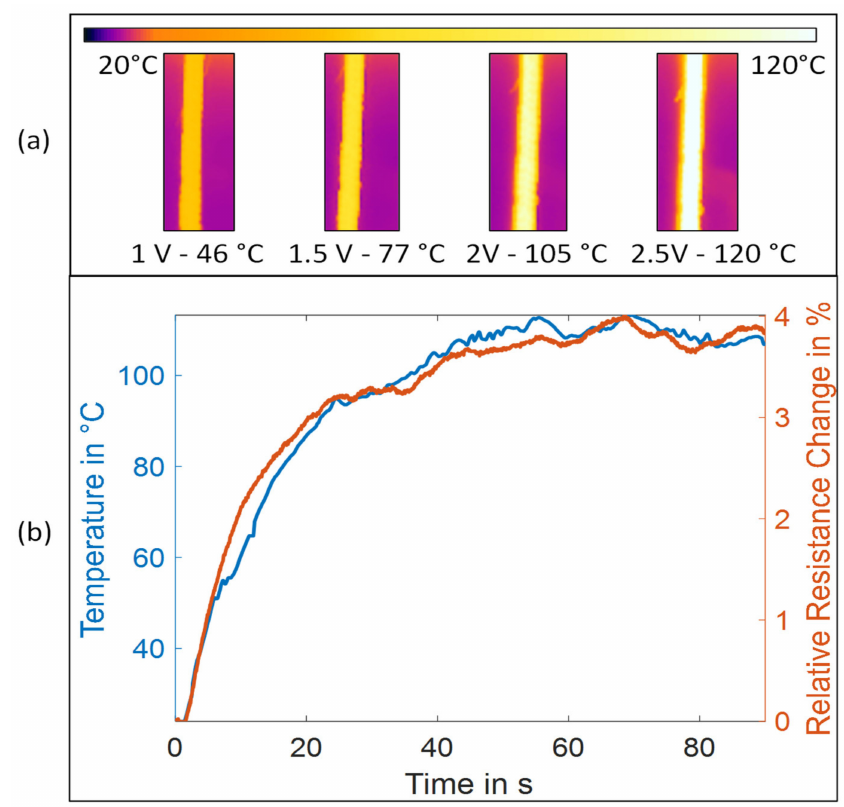
Figure 3. Evaluation of the braided sheath as a temperature sensor: ( a ) SMA braid at varying activation voltage after reaching steady state; and ( b ) relation between temperature and relative resistance change of the copper wire for the activation run with 2